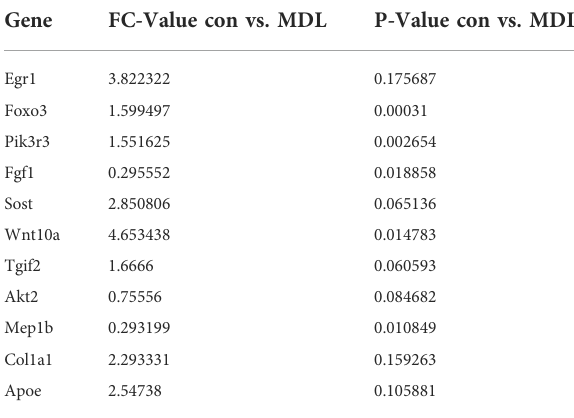
The gray module was a gene set that could not be attributed to any module, so it has no reference signi fi cance. The number of genes in the genes in each module is shown in Figure 5C, and the upper part of the fi gure is the gene clustering tree constructed by the dissTOM matrix constructed by the weighted correlation coef fi cient. The lower part of the Figure 5C shows the distribution of each module gene and the same color represents the same module. If the module features of the two different modules are genetically similar, they are automatically merged. The P earson correlation algorithm was used to calculate the correlation coef fi cient and p value of the module characteristic genes and biochemical indicators. In this experiment, the biochemical indicators were correlated with genes, including weight, fasting blood glucose level after 8 weeks of administration, levels of triglyceride, total cholesterol, serum creatinine and serum urea nitrogen. The heat map can be seen in Figure 5D. In Figure 5D, the vertical axis represents each module and the horizontal axis represents each trait. The result shows the correlation between the module and the trait. We found that the two modules with signi fi cant and inconsistent correlation trends were lightcyan module and cyan module; there are nine modules with signi fi cant correlation with the blank group, including tan, salmon, magenta, red, brown, black, green, yellow and lightyellow module. There were three modules that were signi fi cantly related to the db/db model group, including lightgreen, darkgrey and greenyellow module. Based on the signi fi cance of different modules, we queried the top 50 genes in each screening module for their association with DKD in combination with the network gene database